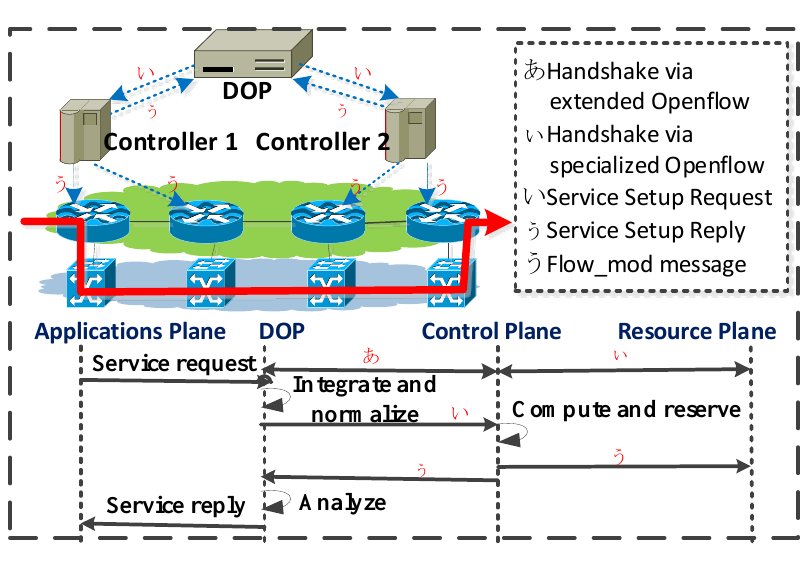
Figure 2. The demonstration for signal process of unified multi-layer